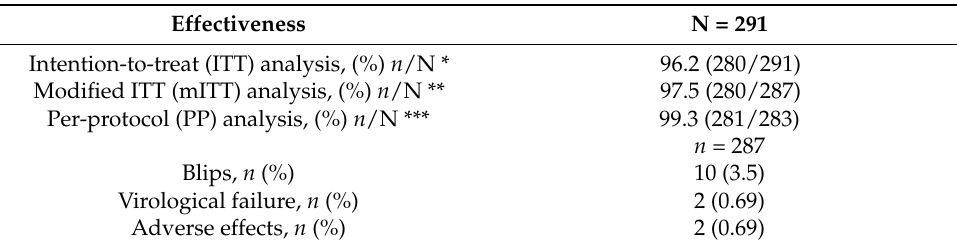
Table 2. Outcomes of RILDO